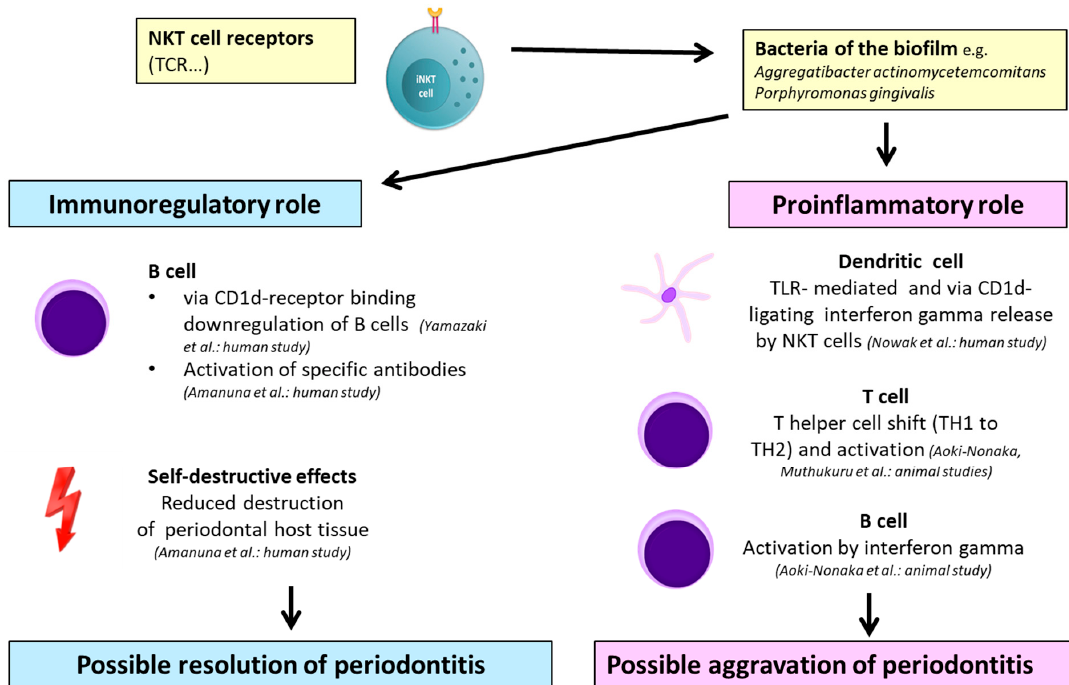
Figure 5. Possible models of NKT cell-mediated mechanisms in periodontitis: The references and experimental study model is given in parentheses (human, animal, and in vitro). NK—natural killer cell; NKT—natural killer T cell; DC—dendritic cell; iNKT cell—invariant natural killer T cell; TH—T helper cell; TCR—T-cell receptor; KIR—killer cell immunoglobulin-like receptor; CRACC—CD2-like receptor-activating cytotoxic cell; NCR-1—natural cytotoxicity triggering receptor 1; IL—interleukin; TLR—Toll-like receptor; and CD—cluster of differentiation.